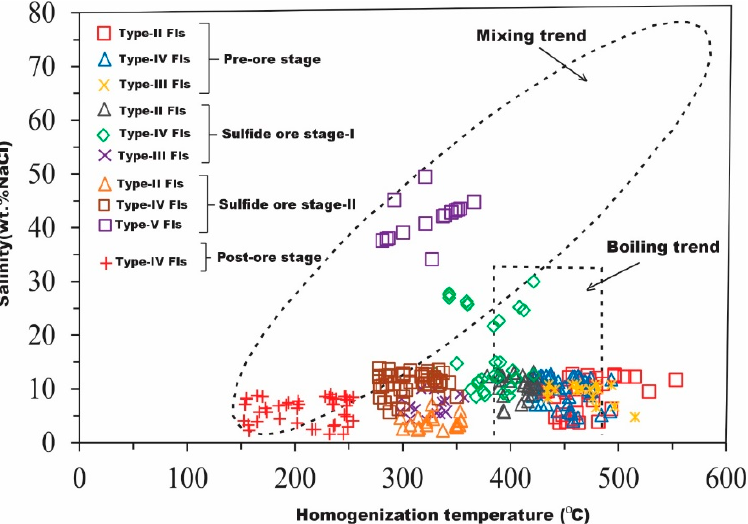
Figure 12. Homogenization temperatures (Th) versus salinity and fluid mixing of fluid inclusions from the Kargah Cu-Pb polymetallic mineralization, (modified after [72]).